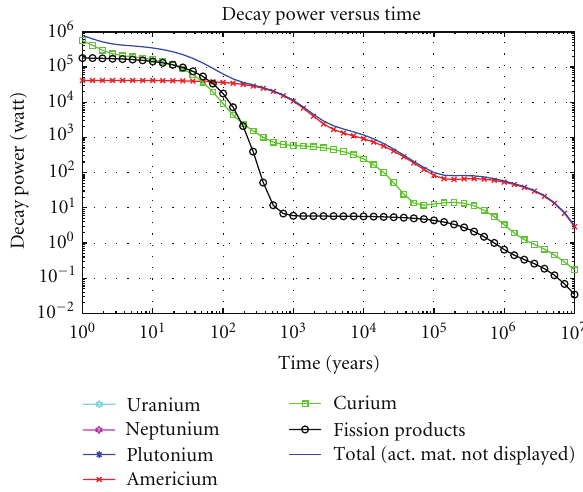
Figure 25: Contributions to heatload versus time—PBMR